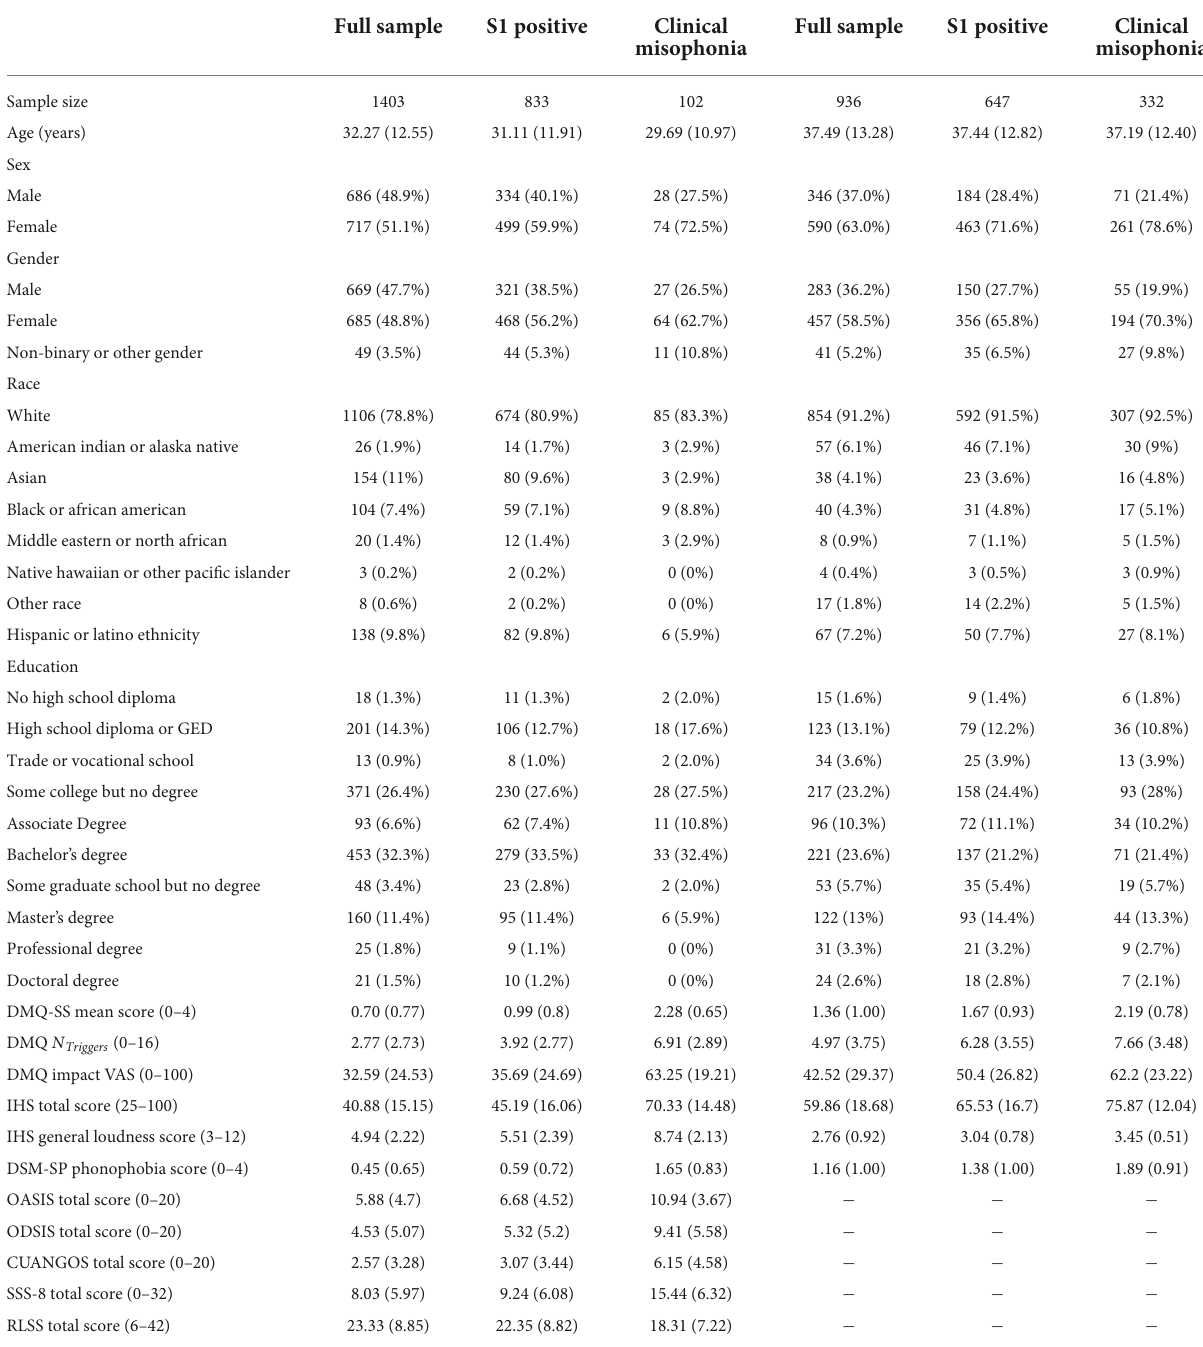
TABLE 3 Demographic and clinical characteristics of Prolific and SPARK